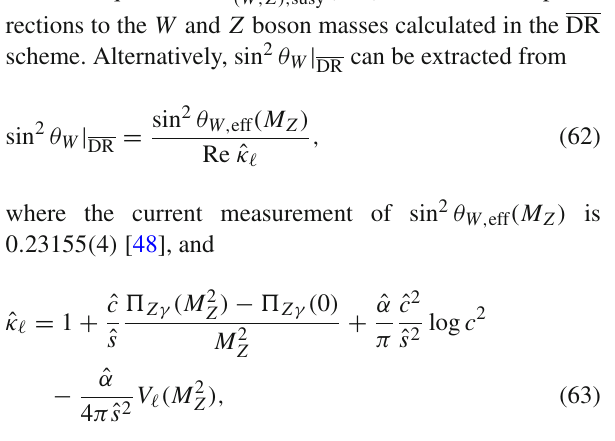
in the range DR